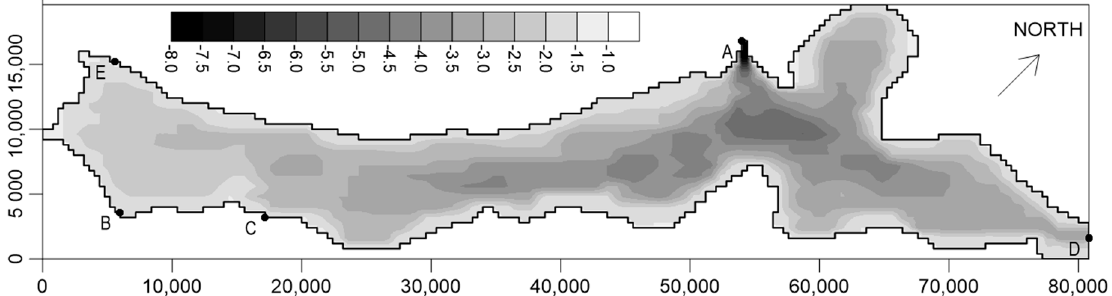
Figure 4. Bathymetry of the Vistula Lagoon (dimensions in meters), point A—Strait of Baltiysk, point B—Nowakowo, point C—Tolkmicko, point D—Kaliningrad, point E—Nowy Ś wiat.